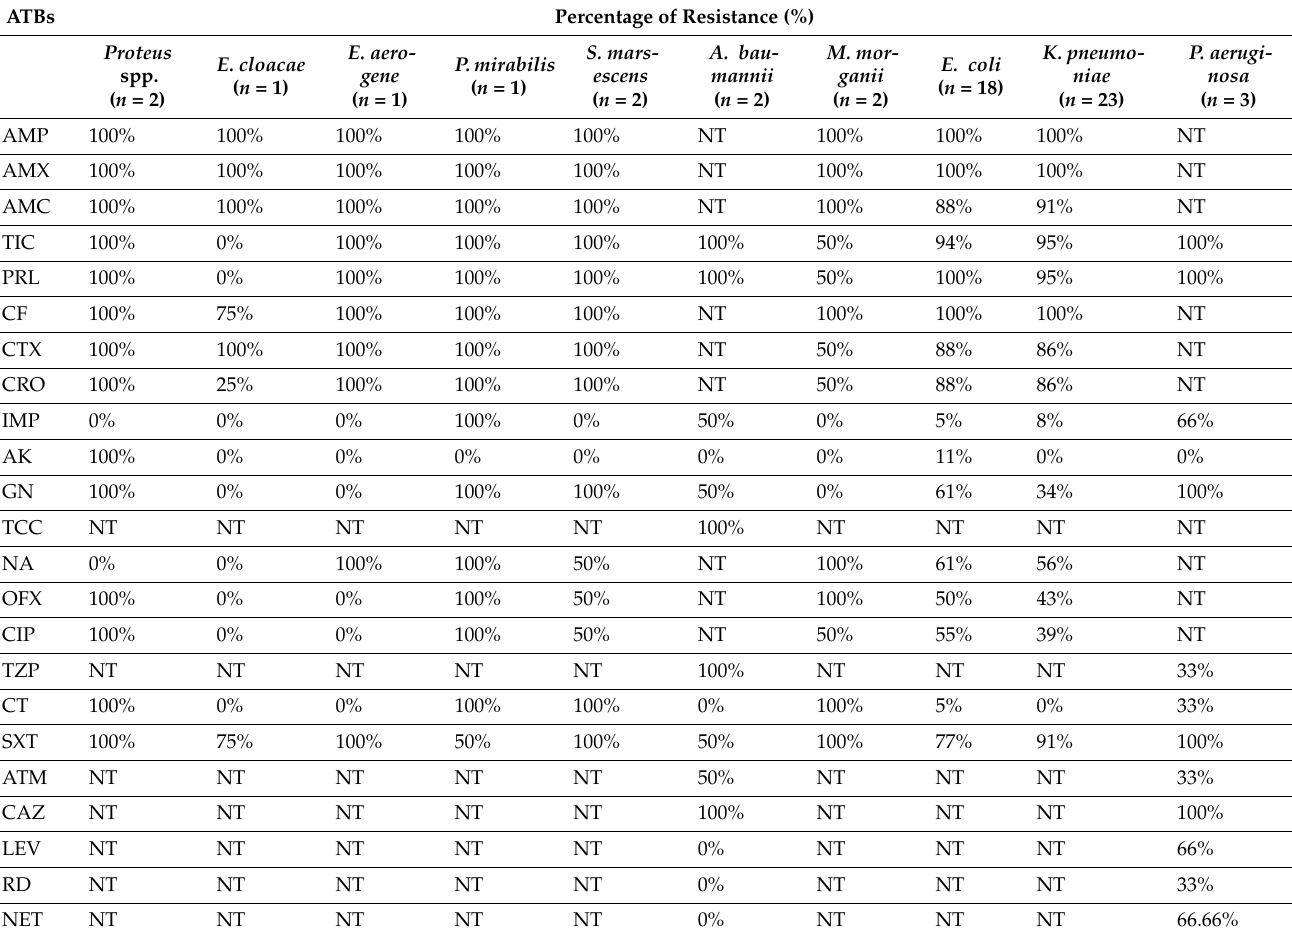
Table 3. Antimicrobial susceptibility patterns of MDR Gram-negative pathogens isolates against commonly used antimicrobials